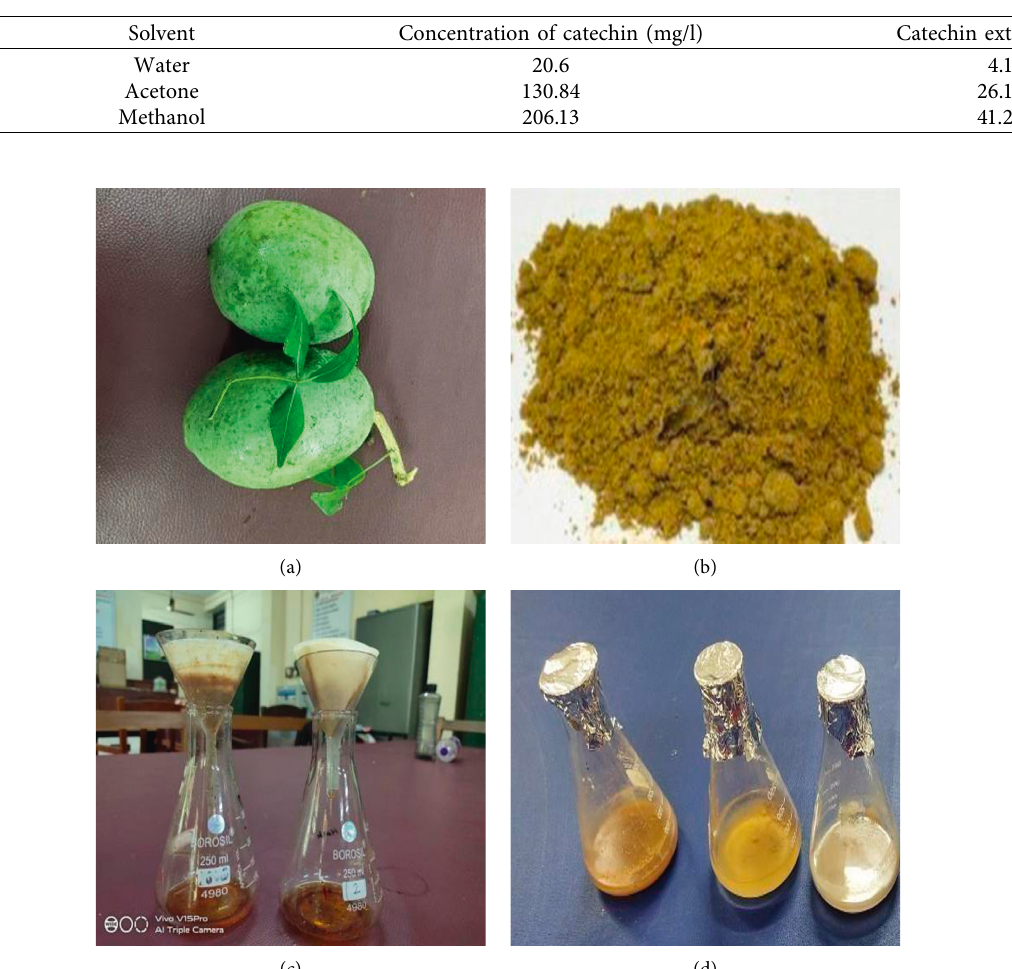
Figure 1: (a) Aegle marmelos fruit; (b) Aegle marmelos fruit powder; (c) extract prepared; (d) extract prepared with different